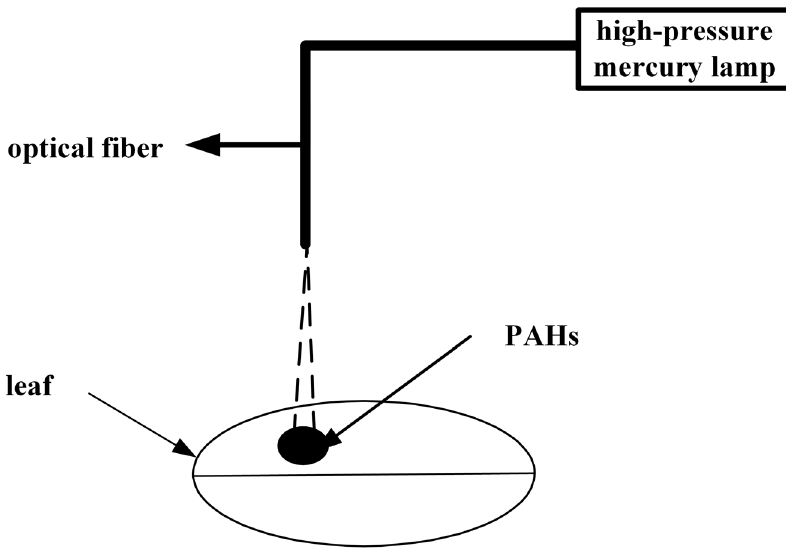
Figure 1. Schematic diagram of the photodegradation of PAHs adsorbed onto the leaves of two mangrove species.